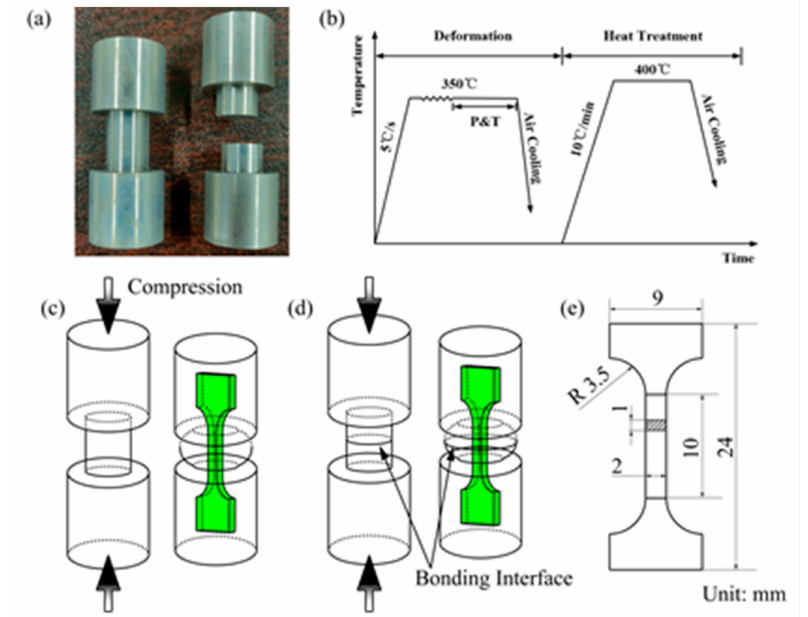
Figure 1. Illustration for the experiments: ( a ) Photograph of the specimens prepared for hot compres- sion; ( b ) Hot compression and post-heating treatment process; ( c ) Schematic of tensile specimens cut from the base material; ( d ) Schematic of tensile specimens cut from the bonded specimen; ( e ) Geome- try and size of the tensile